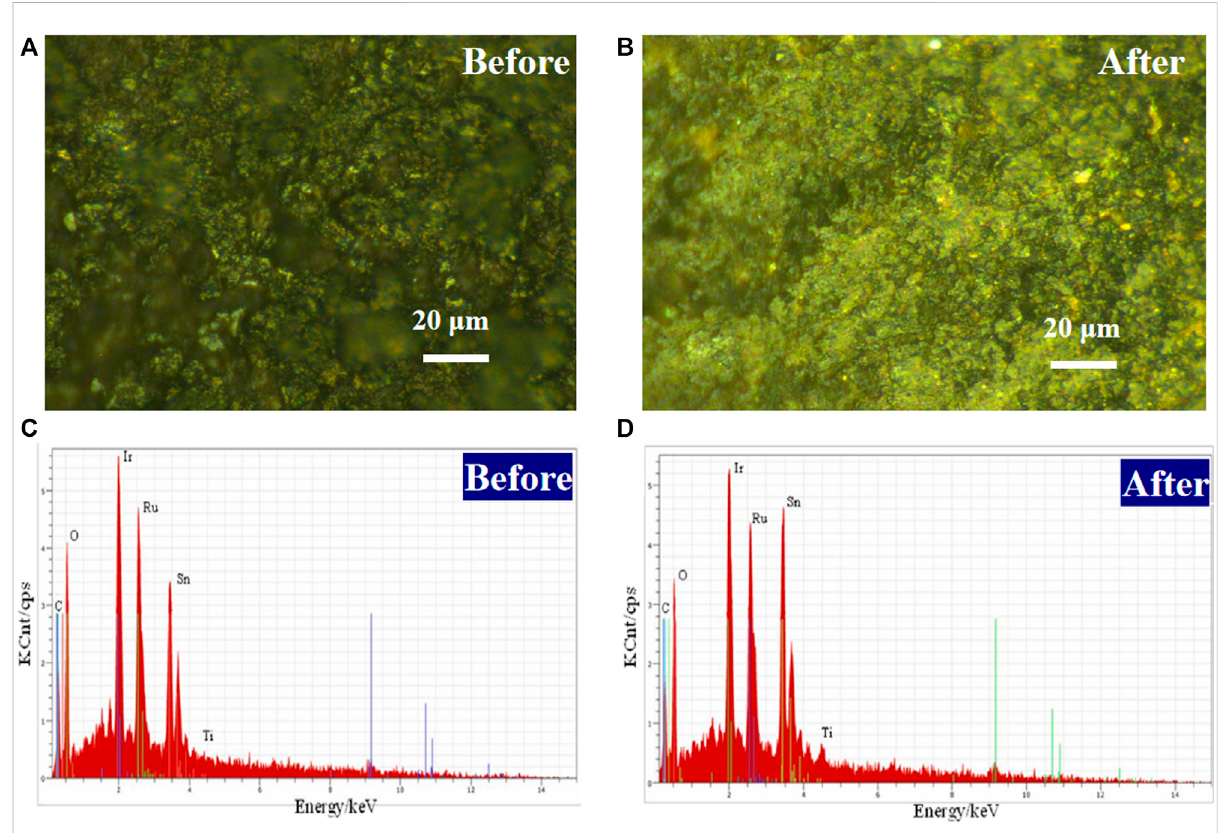
FIGURE 2 SEM micrographs and EDS spectra of DSA before (A,C) and after (B,D) used in the